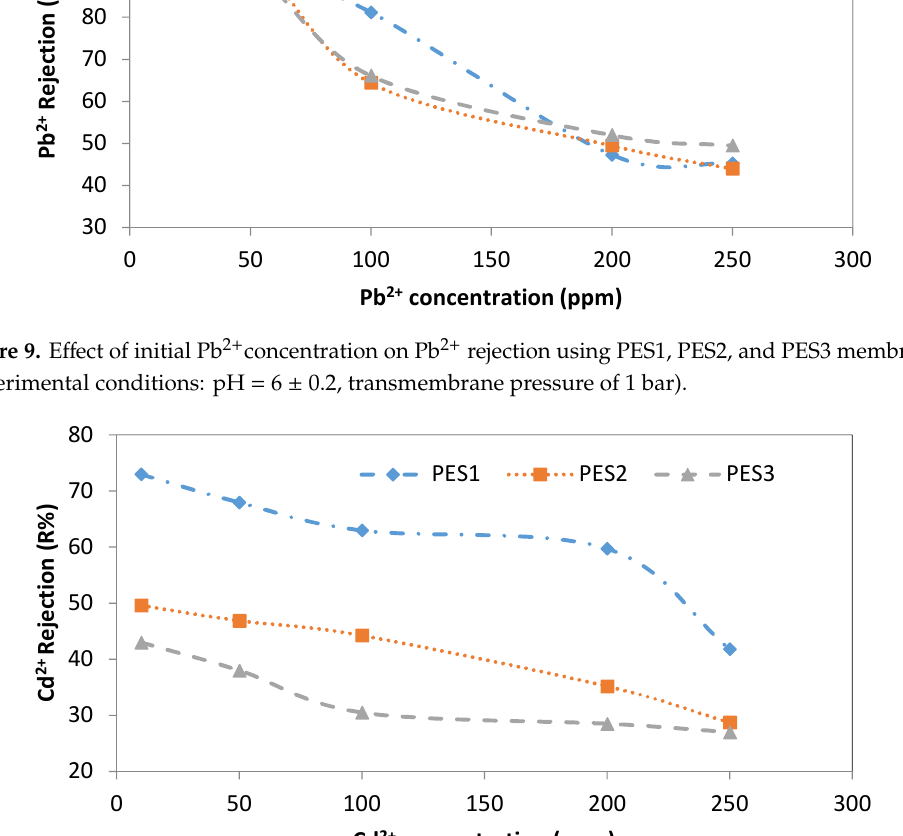
Figure 10. Effect of initial Cd 2+ concentration on Cd 2+ rejection using PES1, PES2, and PES3 membranes (experimental conditions: pH = 6 ± 0.2, transmembrane pressure of 1 bar).